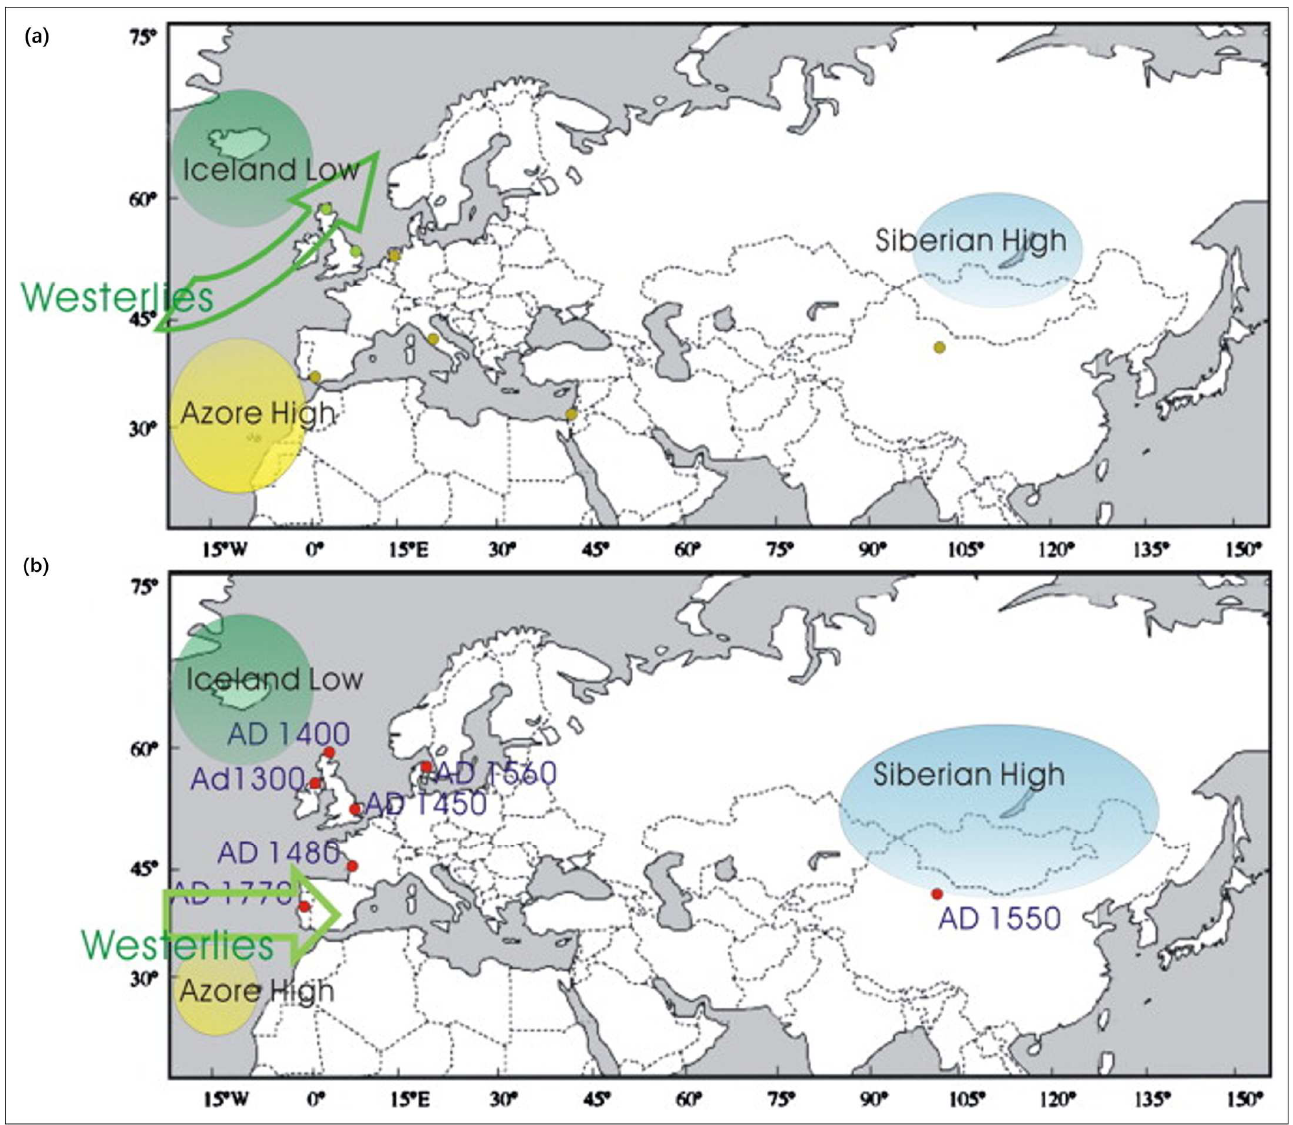
Figure 11. The movement of westerlies controlled by the NAO influence and Siberian High during the Medieval Warm Period ( a ) and Little Ice Age ( b ) (revised from [14,89]). ( a ) the brown dots are dry records and the green ones are wet records during the Medieval Warm Period; ( b ) the red dots are the onsets of the sand invasion event in Europe and drying of Central Asia during the Little Ice Age.